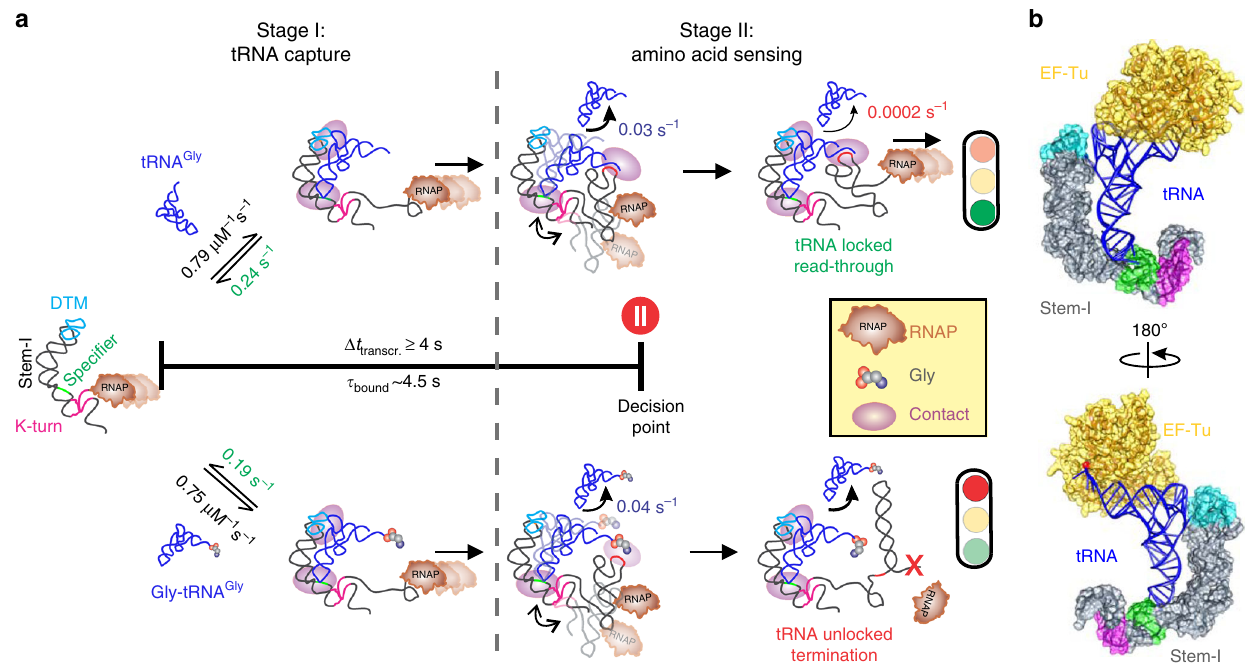
Fig. 8 Kinetic model of aminoacylation-dependent transcription control by the glyQS T-box riboswitch. a Binding and capture of tRNA begins once Stem-I, with the DTM and the Speci fi er sequence, emerges from the RNA polymerase (RNAP). Stem-I binds both the charged and uncharged tRNAs with similar k on and k off . The average bound dwell-time of ~4.5 s is close to the time required for the RNAP to reach the decision point, immediately prior to formation of the terminator where a strong pause site (at position 178, shown using a red pause symbol) is present. Sensing of the aminoacylation state begins with the antiterminator which the bi-stable K-turn positions close to the tRNA 3 ′ -end. The tRNA elbow:DTM interaction can be released in these complexes, leading to dissociation of uncharged tRNA with a k medium